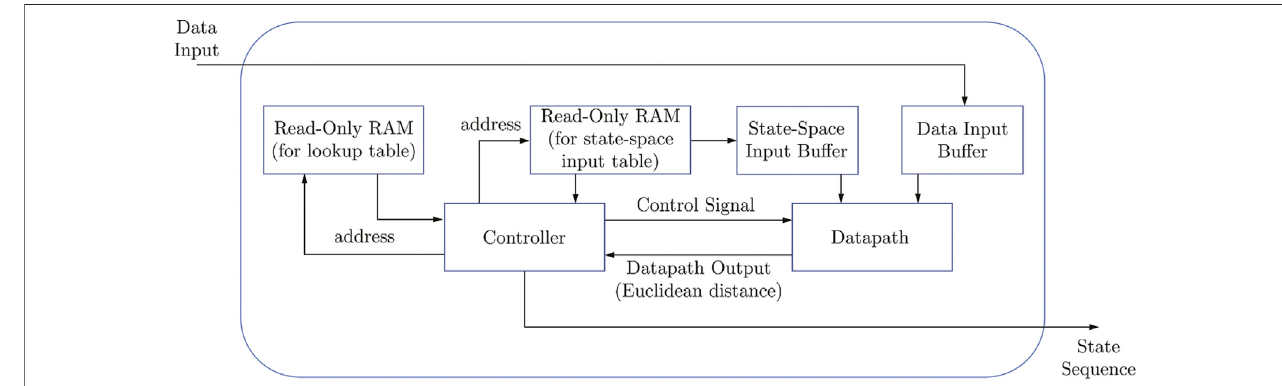
FIGURE 7 | Top level schematic for FSM implementation in FPGA hardware using digital data.